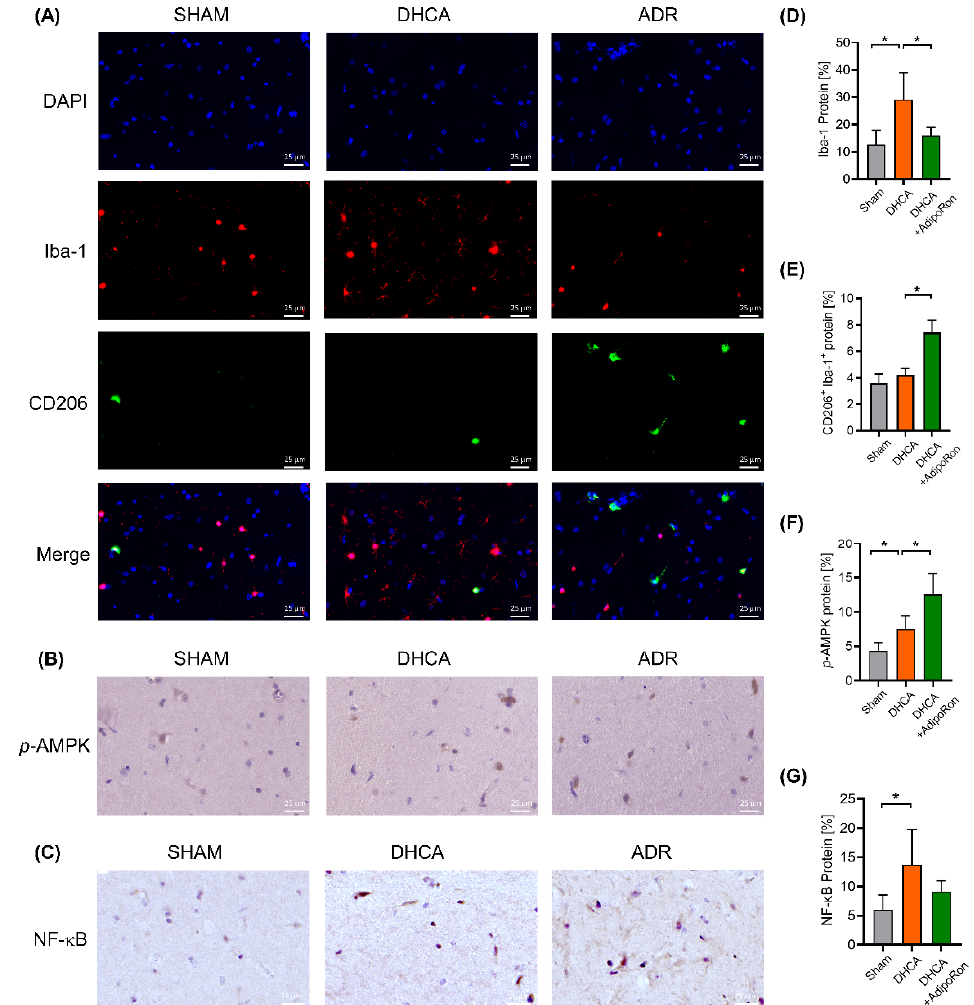
Figure 5. Impact of AdipoRon on Iba-1, CD206, p-AMPK, and NF- κ B protein in rats’ hippocampus. Rats with or without AdipoRon treatment that underwent DHCA were sacrificed and the hippocam- pus tissue was collected at the end of the surgery. ( A ): Immunofluorescence detection of ionized calcium-binding adaptor molecule-1 (Iba-1) and CD206 in hippocamus tissue of the sham group, the DHCA group and the AdipoRon-treated DHCA group. ( B , C ): Immunohistochemistry detection of phosphorylation status of AMP-activated protein kinase (p-AMPK) and nuclear factor κ B (NF- κ B) protein in hippocampus tissue of the sham group, the DHCA group and the AdipoRon-treated DHCA group. A total of 6 animals per group were examined. Representative images are depicted. Scale bar: 25 µ m. ( D – G ): Quantification of Iba-1, CD206, p-AMPK, NF- κ B expressed as the mean expression intensity. The y -axis shows the percentage of positive cell area to total cell area. Student’s t test was used to compare the differences between the DHCA group and the AdipoRon-treated DHCA group. Results are presented as the mean ± SEM, * p < 0.05 .